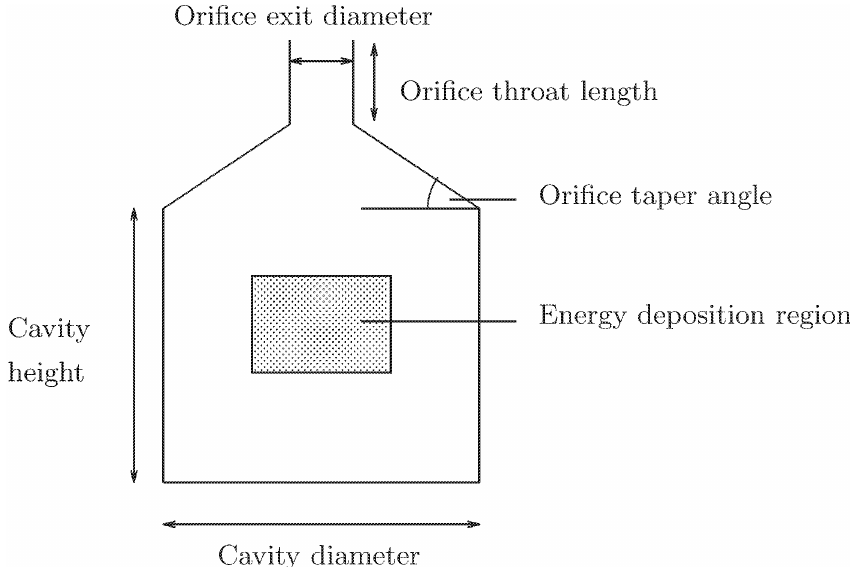
Figure 18. SparkJet